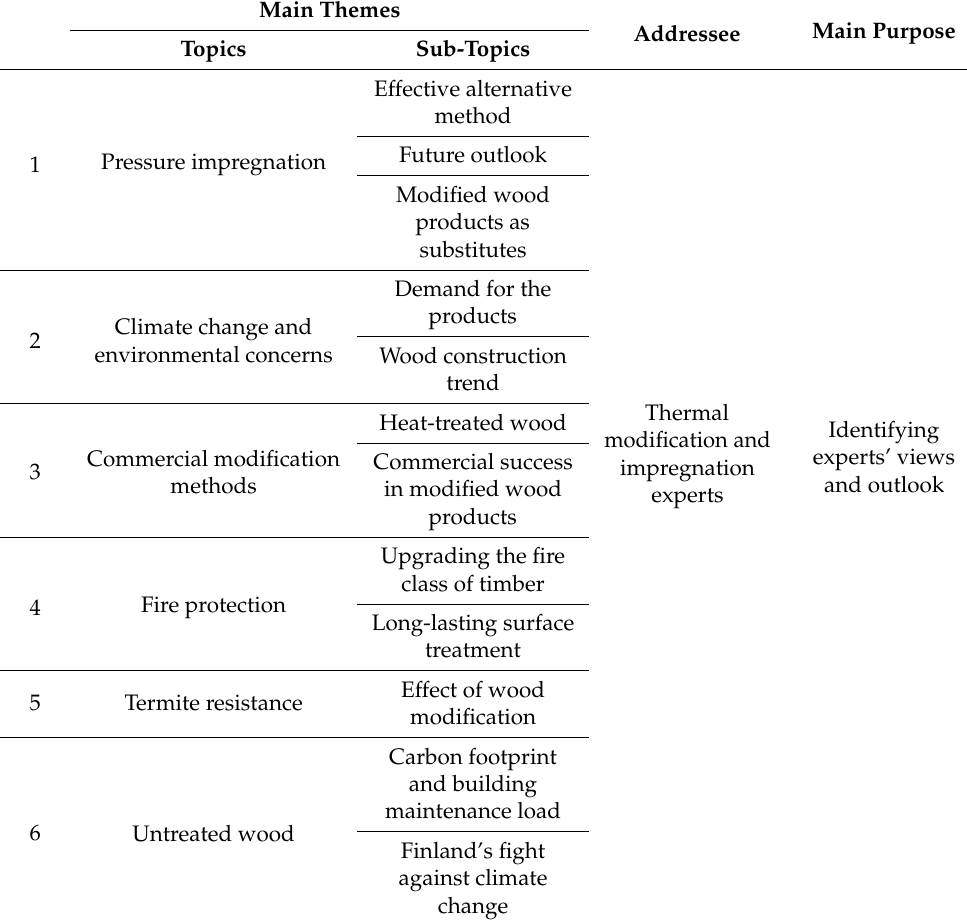
Table 2. The main themes, addressee, and main purpose of the interview questions (Appendix